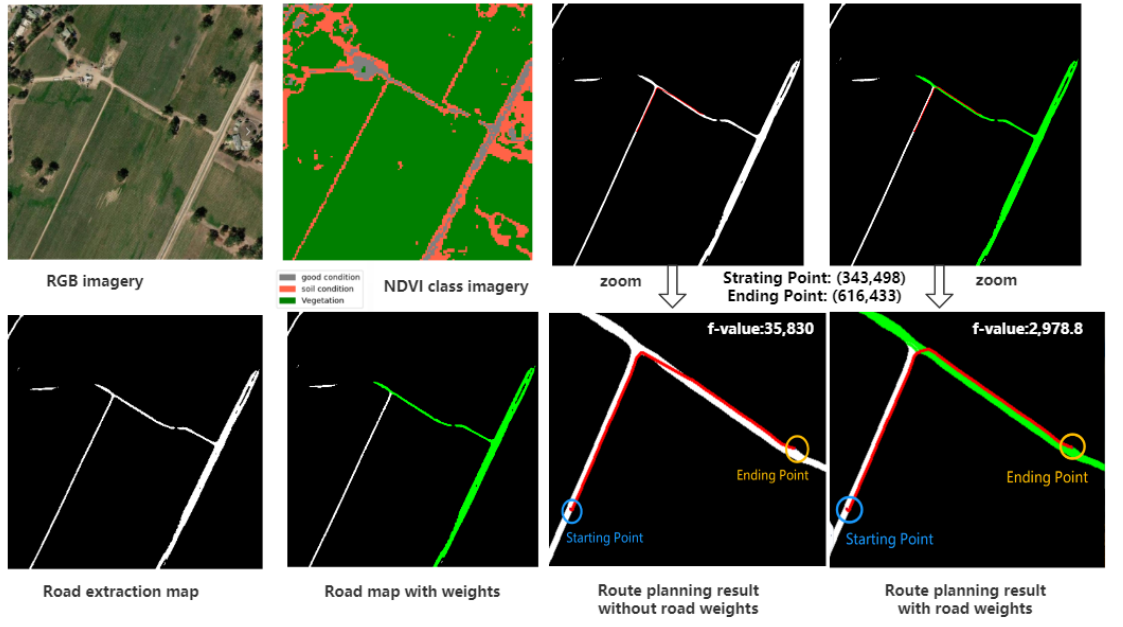
Figure 12. Results of road extraction and optimal path planning on the GeoEye’s OrbView – 3 satellite dataset.